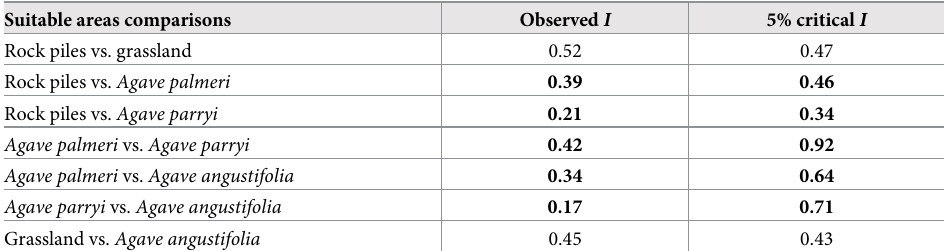
Summary of the observed I values and critical I values calculated using the permutation tests. Significant differences between predicted suitable areas occur when observed I values are lower than the 5% critical I values, indicating non- identical suitable areas for dryland-farming and Agave species. Bold values indicate significant differences between paired suitable areas calculated in the permutation